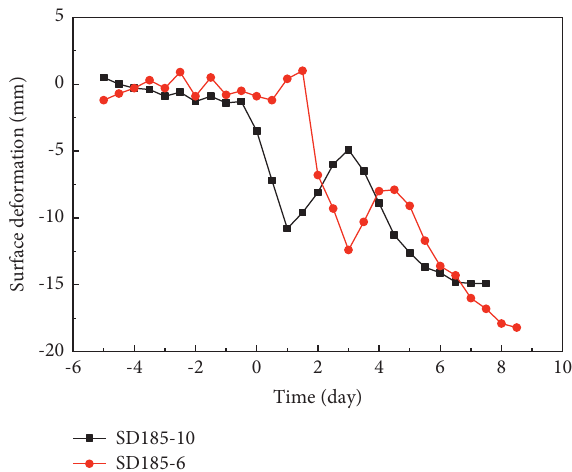
Figure 9: Accumulated deformation curve of SD185 section in Feng-Gu section of Hangzhou Metro Line